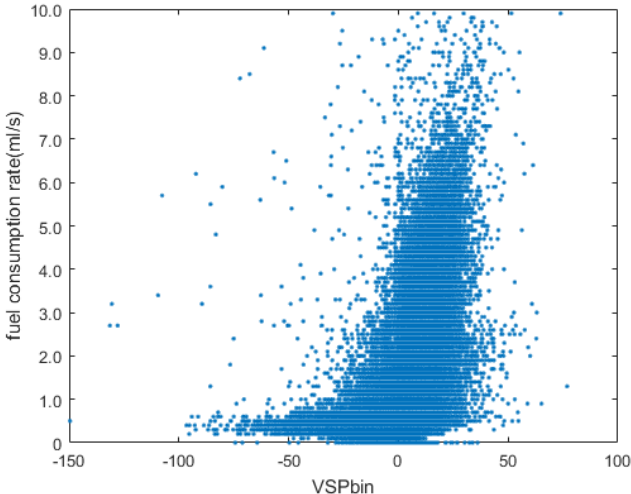
Figure 5. The VSP-fuel consumption scatter plot.